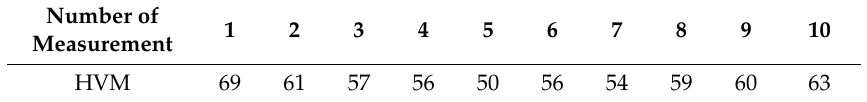
Table 2. The measurement of micro-hardness of the welded joint according to Vickers (HVM).